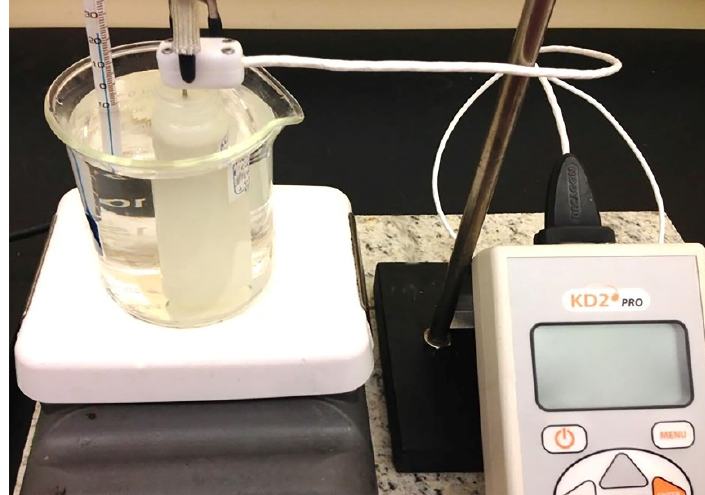
Figure 4. Illustration of configuration used for thermal evaluation for nanolubricants.